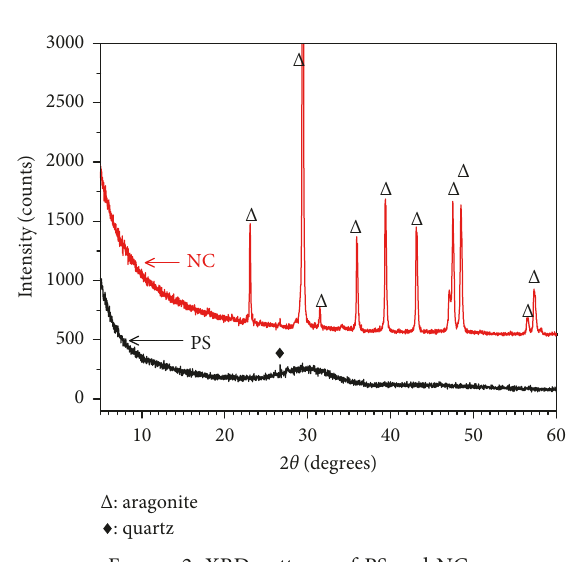
Figure 2: XRD patterns of PS and NC. Table 2: Mix proportion of the